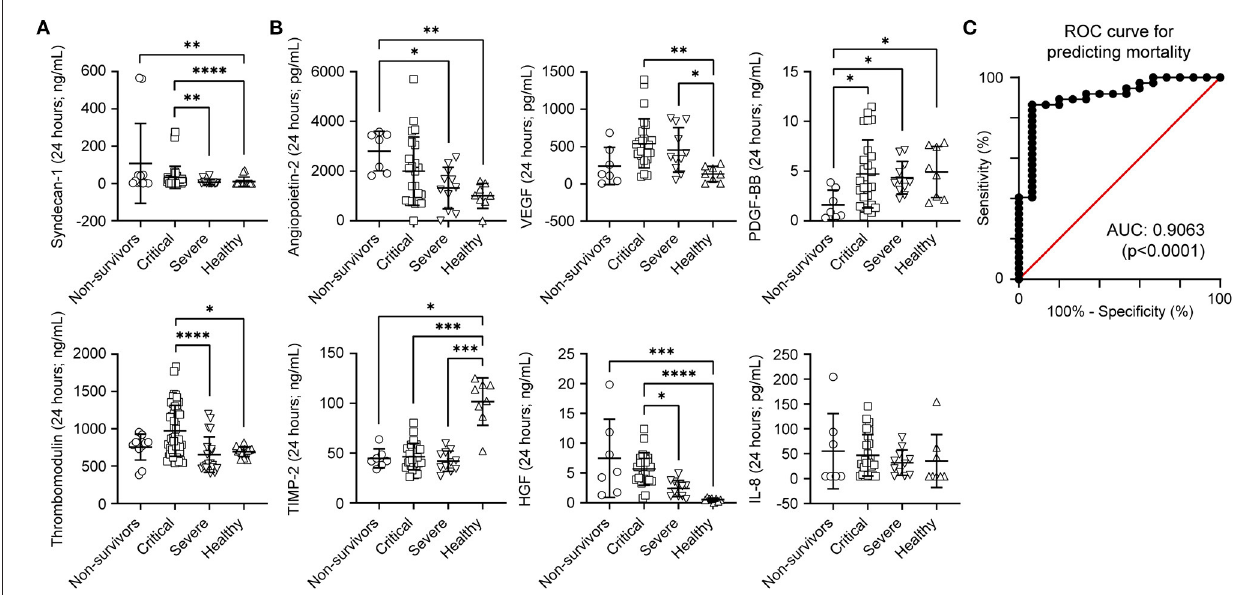
FIGURE 3 | Serum levels comparison according to coronavirus disease 2019 severity during the first 24h of hospitalisation. (A) Levels of syndecan-1 and thrombomodulin. (B) Graph representing the mean serum of angiopoietin-2, vascular endothelial growth factor (VEGF), human platelet-derived growth factor (PDGF), human tissue inhibitor of metalloproteinases-2 (TIMP-2), human hepatocyte growth factor (HGF), and human Interleukin-8 (IL-8). Statistical significance ( P -values) is obtained using two-sided Kruskal–Wallis test, * P < 0.05; ** P < 0.01; *** P < 0.001; **** P < 0.0001. (C) Multivariate model logistic regression receiver operating characteristic curve using TIMP-2 and PDGF for predicting mortality ( n = 11 severe, n = 25 critical, n = 7